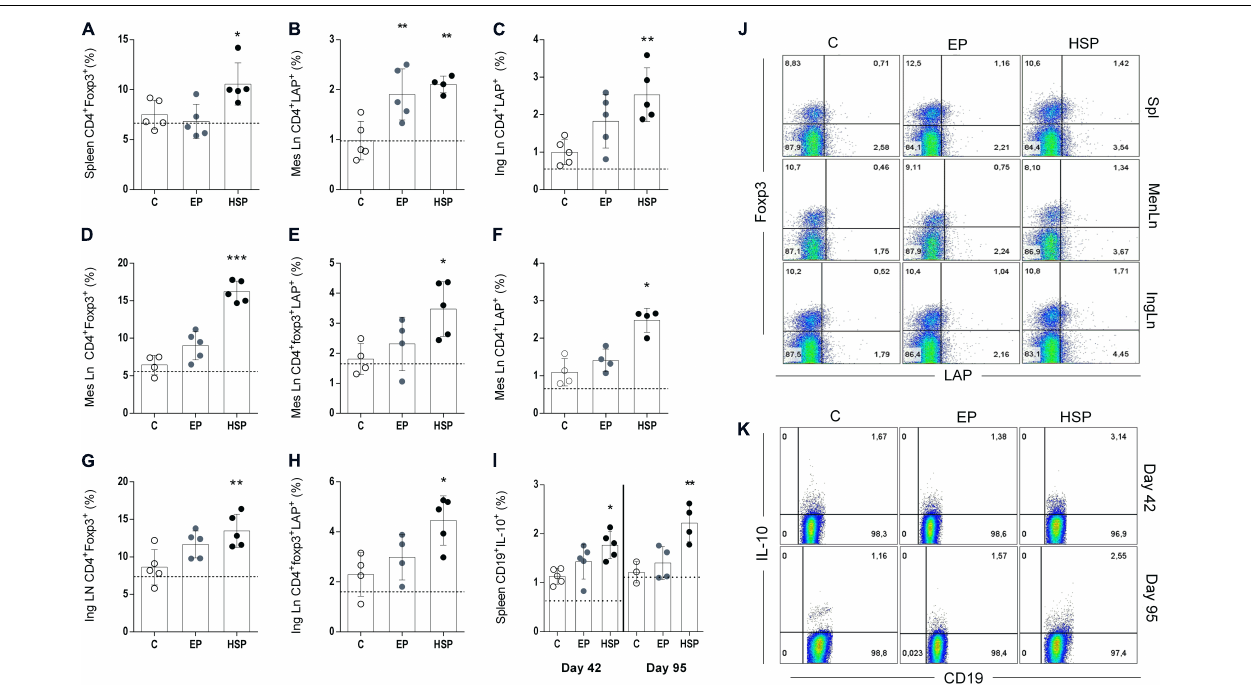
FIGURE 4 | Oral treatment with Hsp65-producing L. lactis increased the frequencies of regulatory T lymphocytes. BALB/c mice were fed either XM17 broth only (C group), L. lactis -EP (EP group) or Hsp65-Lac (HSP group) for four days. Non-manipulated naïve animals were used to obtain basal levels (N group, dashed line). Ten days after treatment the arthritis was induced with four injections of CII + OVA in CFA, as in the CIA protocol. Spleen, mesenteric and inguinal lymph nodes were collected after the second immunization (day 42) and at day 95 for flow cytometry analysis. Frequencies of CD4+CD25+ from spleen cells collected at day 42 and positive for foxp3 (A) ; CD4+CD25+ from mesenteric lymph nodes that were LAP+ (B) ; CD4+CD25+ cells from inguinal lymph nodes obtained at day 42 that were LAP+ (C) ; CD4+CD25+ mesenteric lymph node cells obtained at the end of the experiment (day 95) that were Foxp3+ (D) Foxp3+LAP+ (E) , and LAP+ (F) . Cells from inguinal lymph nodes collected at day 95 stained for CD4+CD25+Foxp3+ (G) and CD4+Foxp3+LAP+ (H) . Spleen cells collected after second immunization (day 42) and at day 95 and stained for CD19 and IL-10 (I) . Representative plots of cellular populations gated from CD4+CD25+ cells (J) . Representative plots of CD19 + IL10 + cells from spleen (K) . Values represent the mean ± SEM. * p < 0.05 compared to control C group. ** p < 0.005 compared to control C group. *** p <